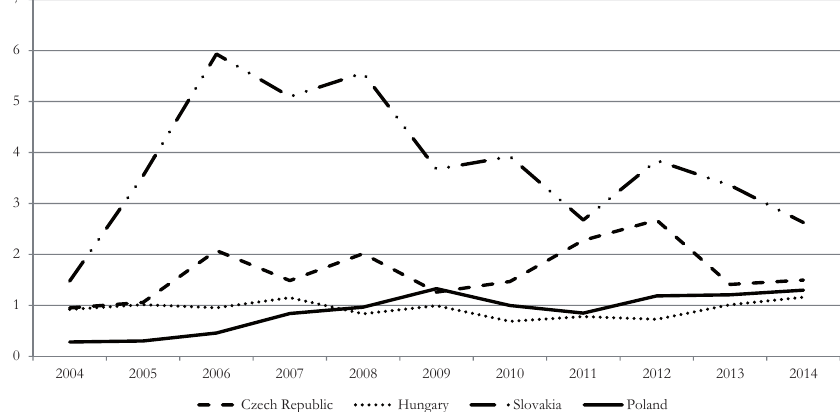
Fig. 3 – The average Euclidean distance between the capital region and other regions over the period of 2004-2014. Source: Author’s own